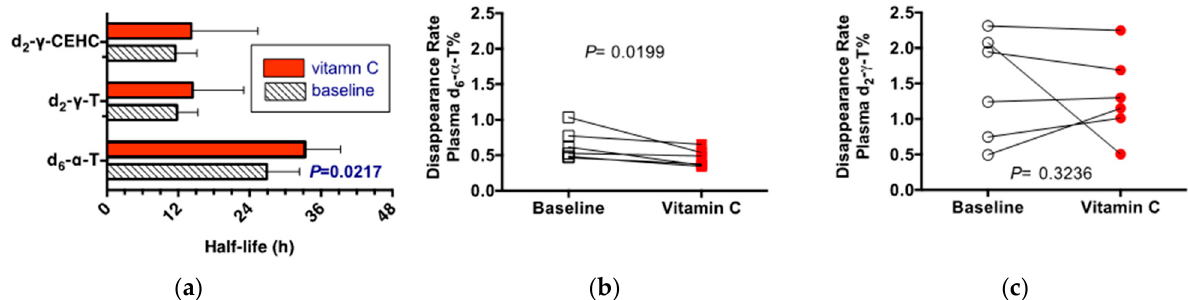
Figure 3. The plasma half-lives in hours for d 6 - α - and d 2 - γ tocopherols and d 2 - γ CEHC. Half-lives indicate the length of time for half of the indicated compound to leave the plasma compartment ( a ). Individual data shows disappearance rates (pools per day) by person (( b ) d 6 - α tocopherol; ( c ) d 2 - γ tocopherols). The rates shown are based on the percentage labeled to demonstrate that the baseline tocopherol concentrations did not impact the outcomes.